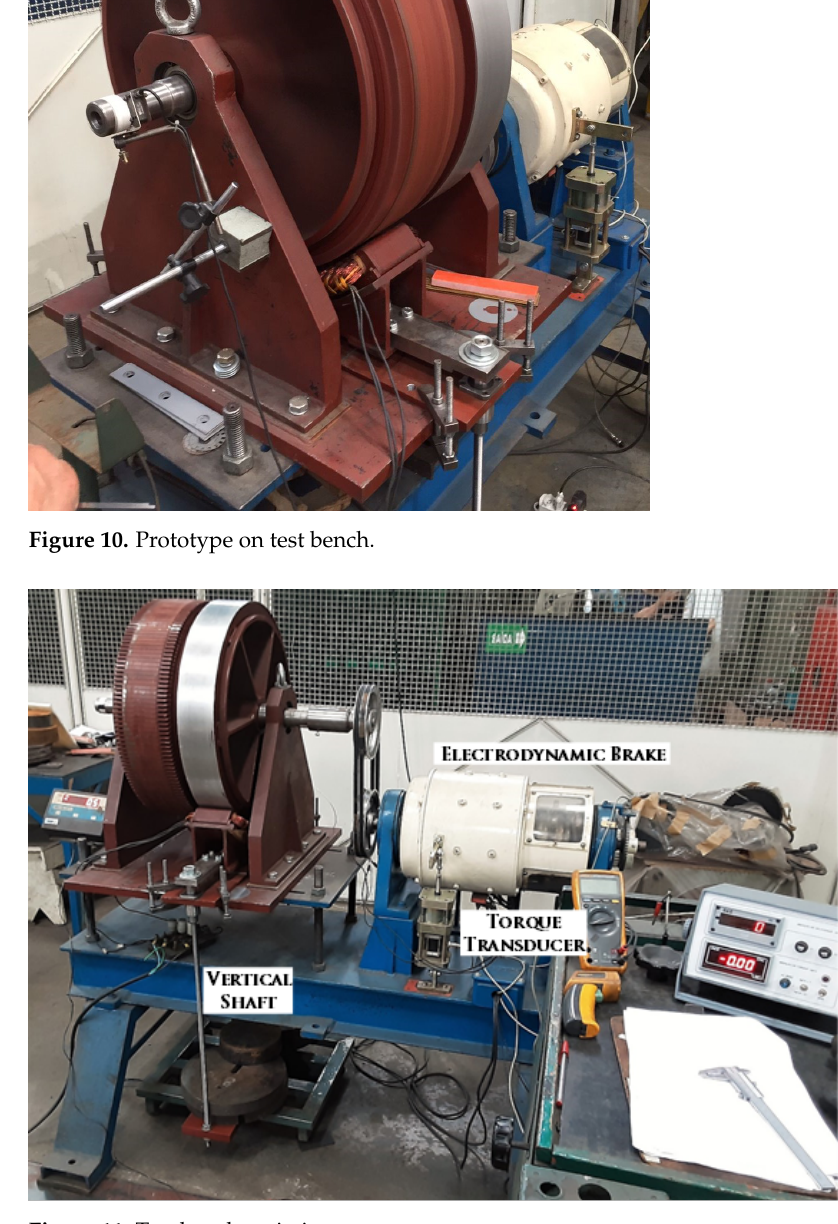
Figure 11. Test bench main